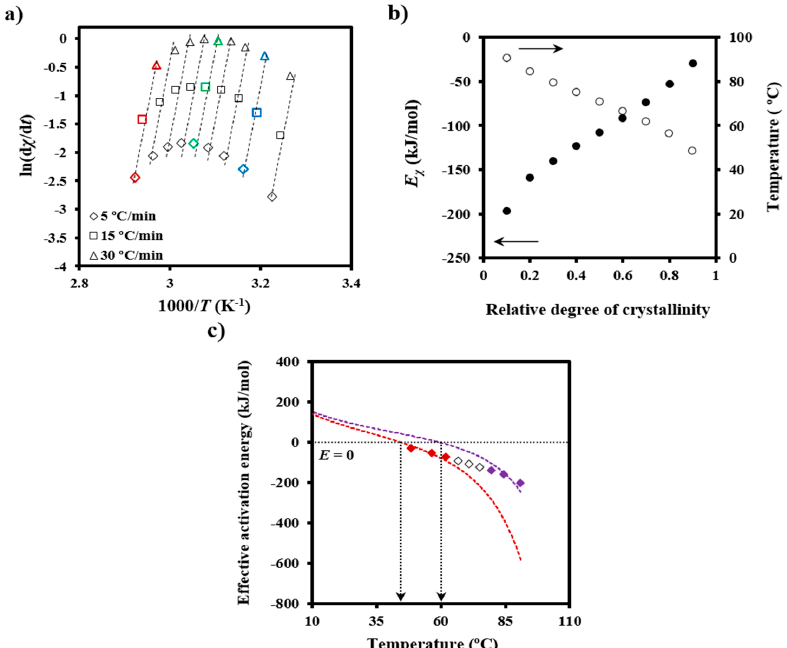
Figure 5. ( a ) Plots of ln[d χ /d t ] χ versus 1/ T for non-isothermal crystallization of PDO at the indicated cooling rates. Data corresponding to relative degrees of crystallinity of 0.8, 0.5 and 0.1 are represented by blue, green and red symbols, respectively; ( b ) Dependence of the activation energy of crystallization ( ● ) and average temperature ( ○ ) on crystallinity; ( c ) Experimental E χ versus T plot and simulated curves according to Equation (6). Red and violet dashed lines indicate the simulated curves for regimes III and II, respectively. Arrows indicate the expected temperatures for the maximum crystallization rates (i.e., effective activation energy equal to zero).